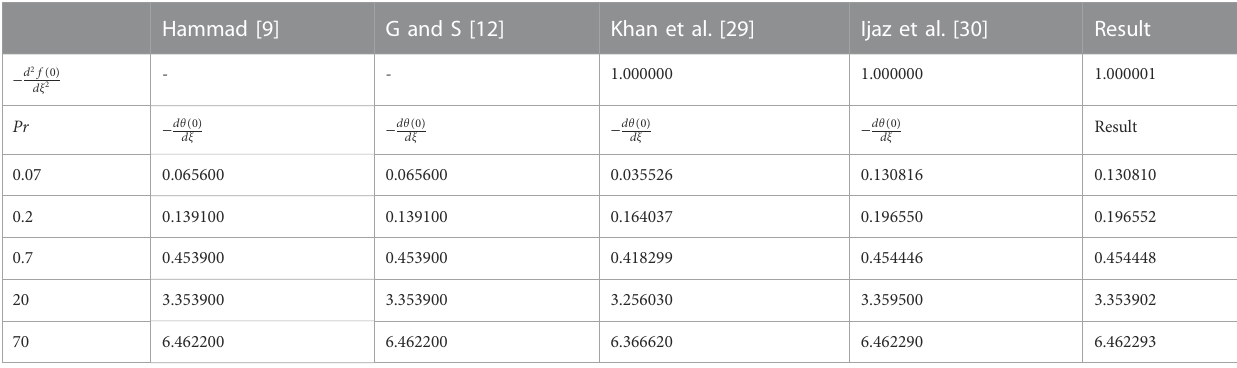
TABLE 1 Comparison of numerical results ξ → ∞ with published results.